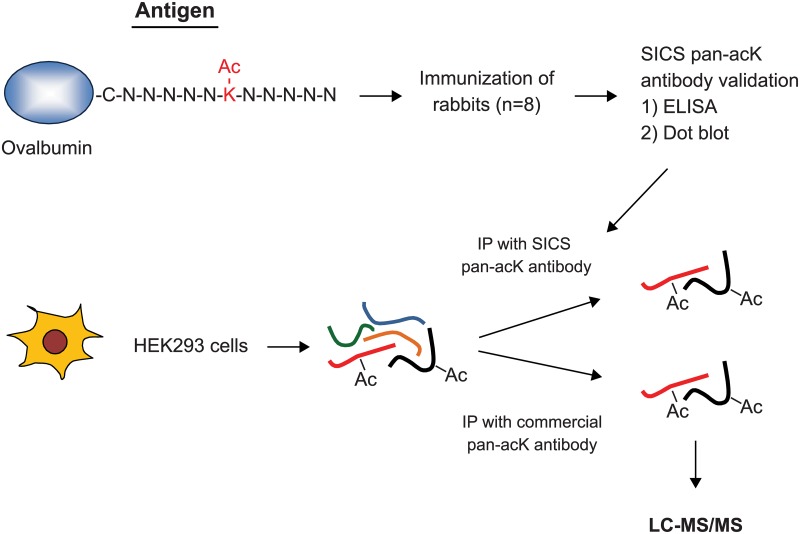
Strategy for pan-acetyl-lysine antibody generation and application in acetylome studies.To generate pan-acetyl-lysine (acK) antibody, a random acK peptide library conjugated to ovalbumin was used as an antigen to immunize rabbits. Raised antibodies were tested for specificity with ELISA and dot blot, and those that passed quality control were used to pull down acK peptides from HEK293 cell lysate for analysis by LC-MS/MS. A commercial pan-acK antibody was used for comparison.